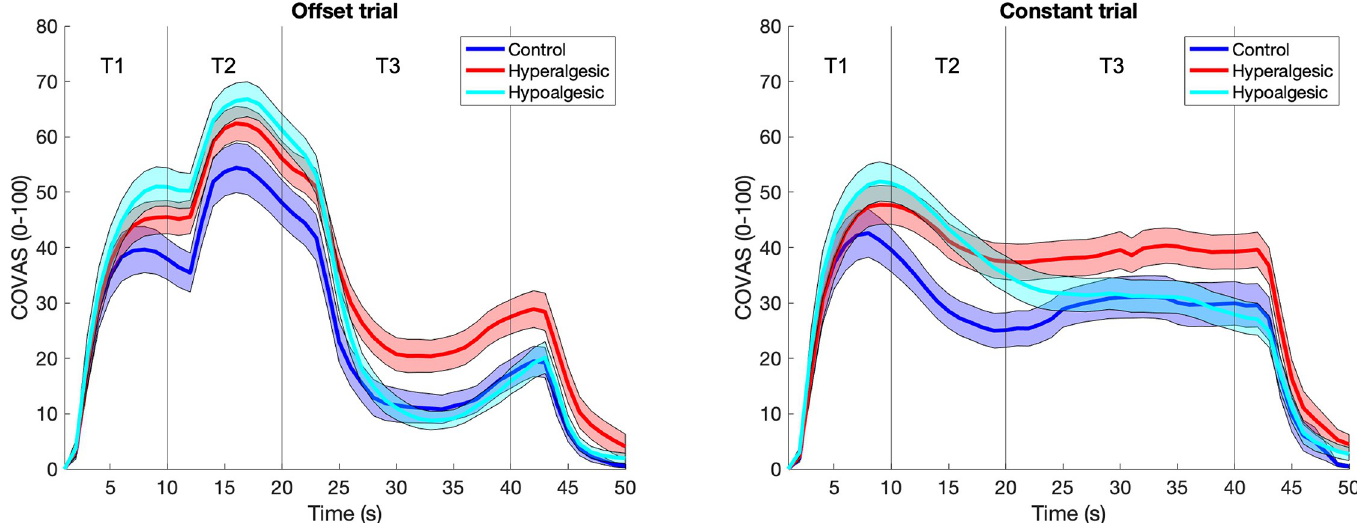
Fig 2. Pain ratings in offset analgesia (left) and constant trials (right). Note that in offset analgesia trials, pain was disproportionally reduced during the last 20s of thermal stimulation assessed via a computerized visual analog scale (COVAS). Hyperalgesic suggestion inhibited the development of profound analgesia present in the control as well as the hypoalgesic group. Suggestion affected constant trials in a similar fashion. Bold curves represent mean pain whereas shaded zones are standard errors of the mean (SEM).